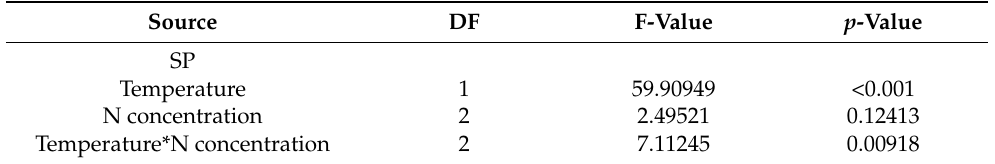
Figure 6. Contents of soluble protein (SP) of S. horneri under LN, IN, and HN treated by CT and ET. Data are means ± SD (n = 3). Horizontal lines represent significant differences ( p < 0.05) among the temperature levels at the same N concentration, the different capital letters represent significant dif- ferences ( p < 0.05) among N concentrations at the elevated temperature, while the different lower-case letters represent significant differences ( p < 0.05) among N concentrations at the ambient temperature. Table 7. Results of two-way ANOVA for soluble protein (SP) of S. horneri under LN, IN, and HN, treated by CT and